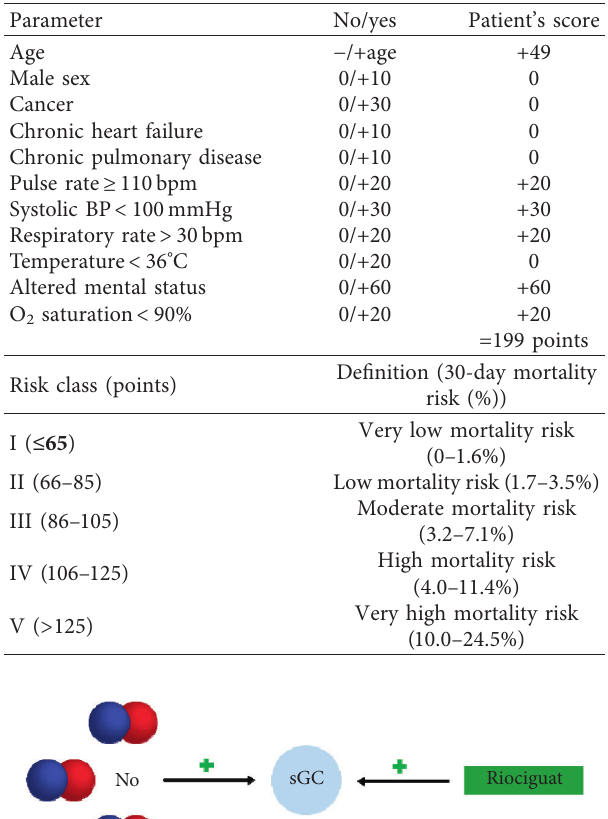
Table 2: Original pulmonary embolism severity index